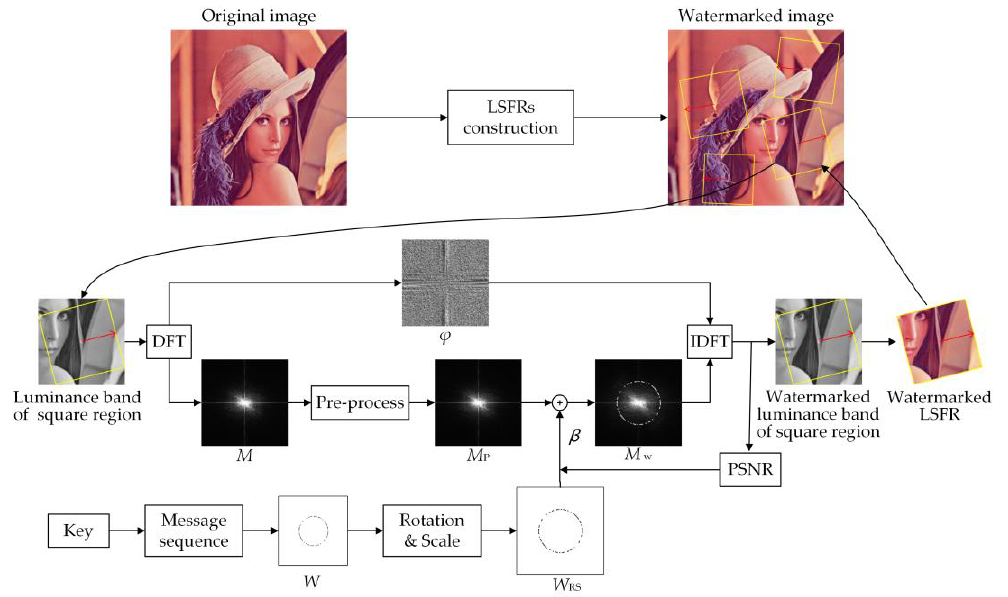
Figure 7. Framework of watermark embedding process.